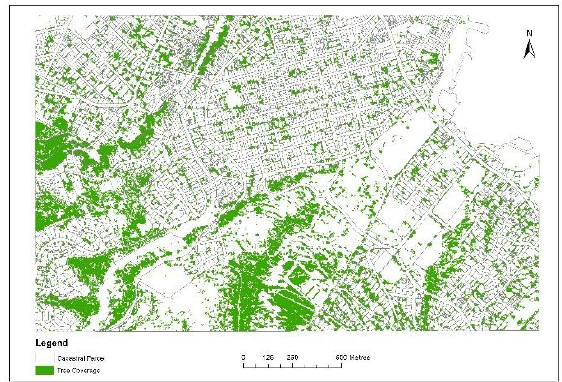
Figure 10. An overlay of urban trees layer generated from object-based CNN method over cadastral parcel layer within the study area.